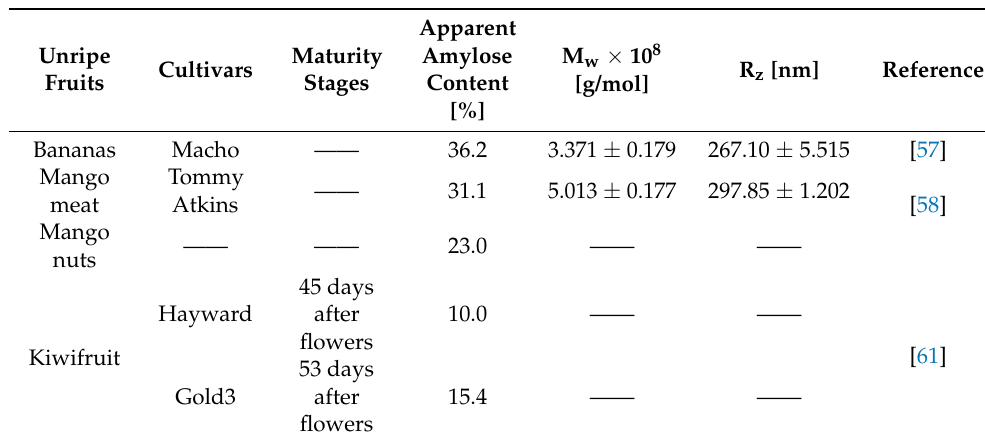
Table 4. Starch content in unripe